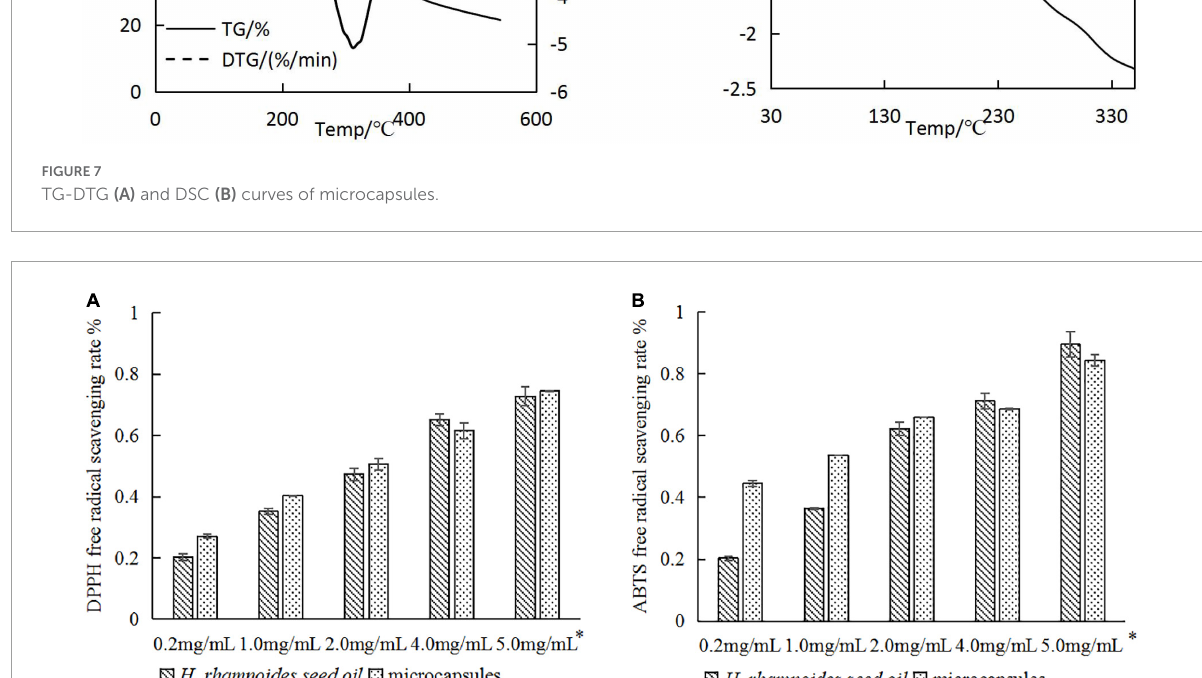
FIGURE8 Comparison of antioxidant activity of H. rhamnoides seed oil and microcapsules: (A) DPPH free radical scavenging rate; (B) ABTS free radical scavenging rate. *Actual concentration of H. rhamnoides seed